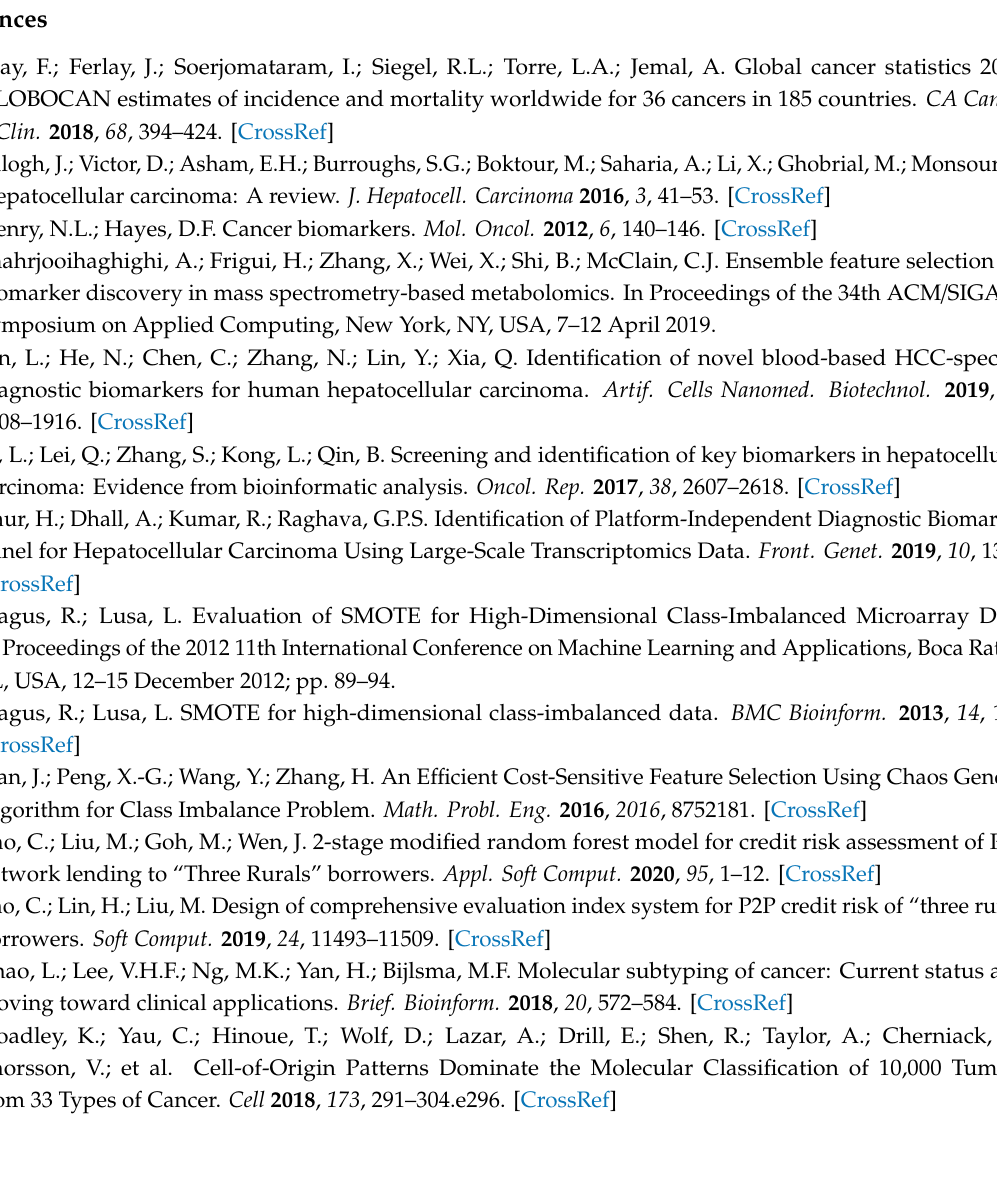
Figure S1: The flowchart regarding the classification of the samples; Figure S2: The results of the Fisher ratio; Figure S3: Screen plot of 300 representative genes; Figure S4: The bubble diagram of functional enrichment; Figure S5: The heatplot for the molecular subtypes, pathologic stage, and TNM staging; Table S1: The detailed information for the 34 DEGs; Table S2: Function enrichment analysis of the 34 DEGs; Table S3: Pathway enrichment analysis of the 34